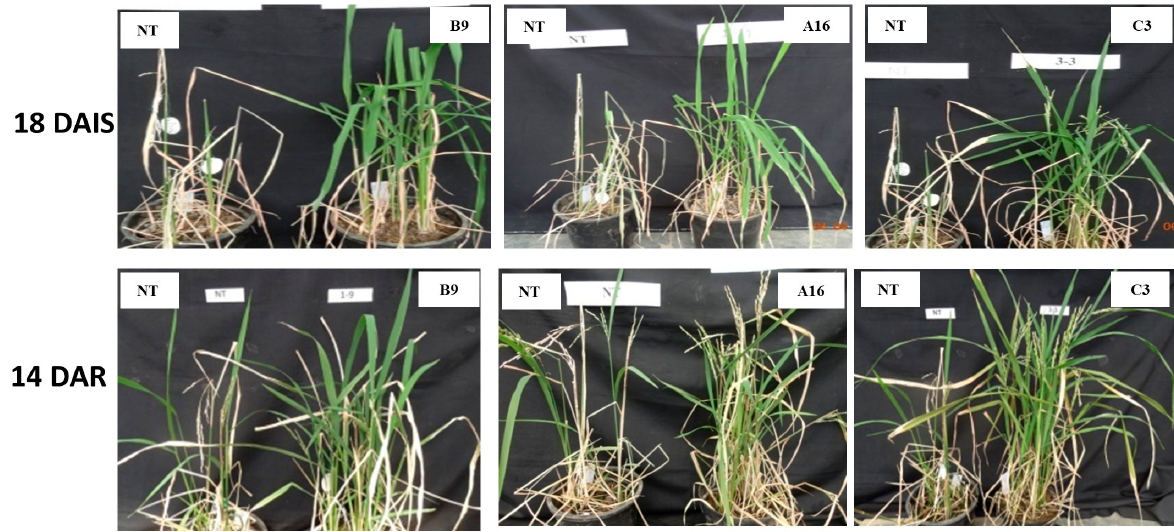
Figure 2. Responses of transgenic and non-transgenic ADT43 (T 1 ) lines to drought (18 DAIS) and re-watering (14 days after re-watering).